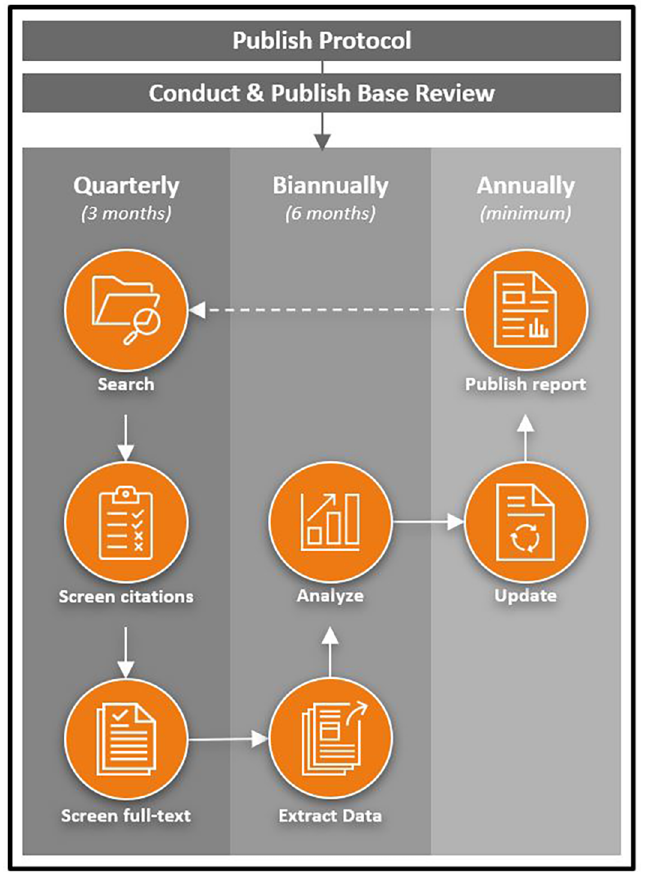
Figure 3. Living review workflow. Note. Arrows represent stages involved in a static systematic review; the dotted line (from “ Publish Report ” to “ Search ” ) represents the stage at which the review process is repeated from the beginning while the review remains in living